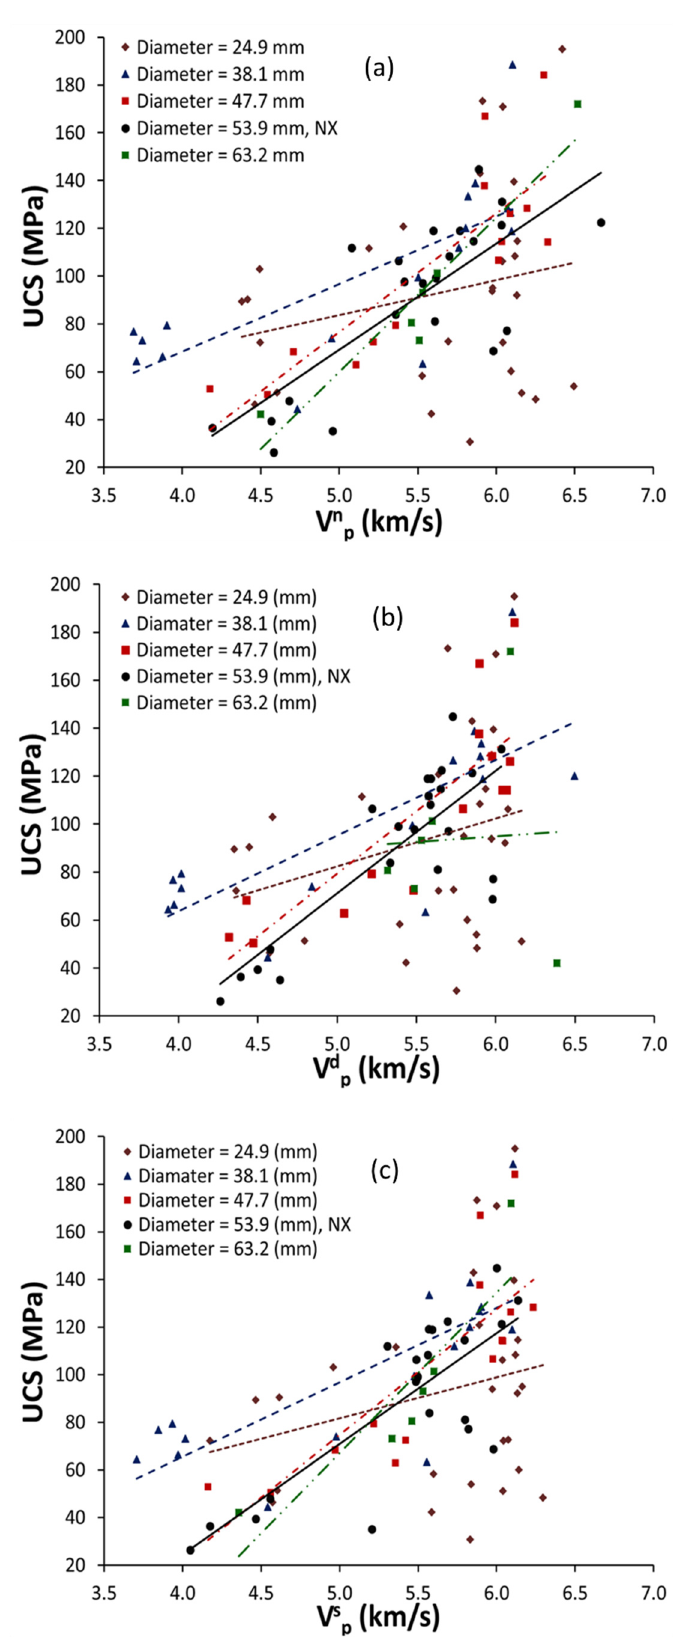
Figure 1. Variation in uniaxial compressive strength (UCS) values. UCS plotted as a function of ( a ) V np , ( b ) V dp , and ( c ) V sp for different sample diameters.